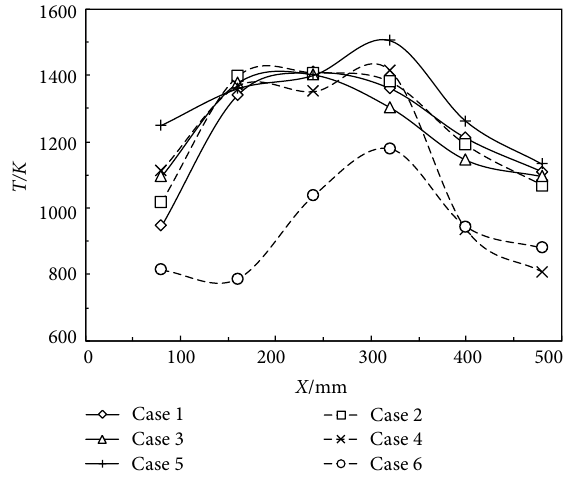
Figure 6: The actually measured temperature distribution on the flame trajectory.